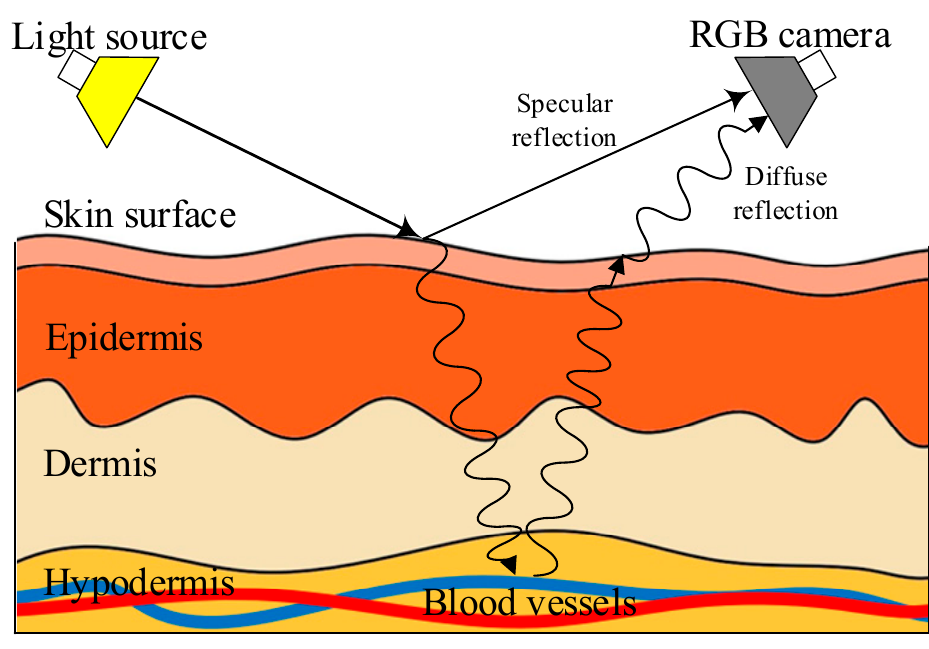
Figure 4. Schematic diagram of rPPG technology.